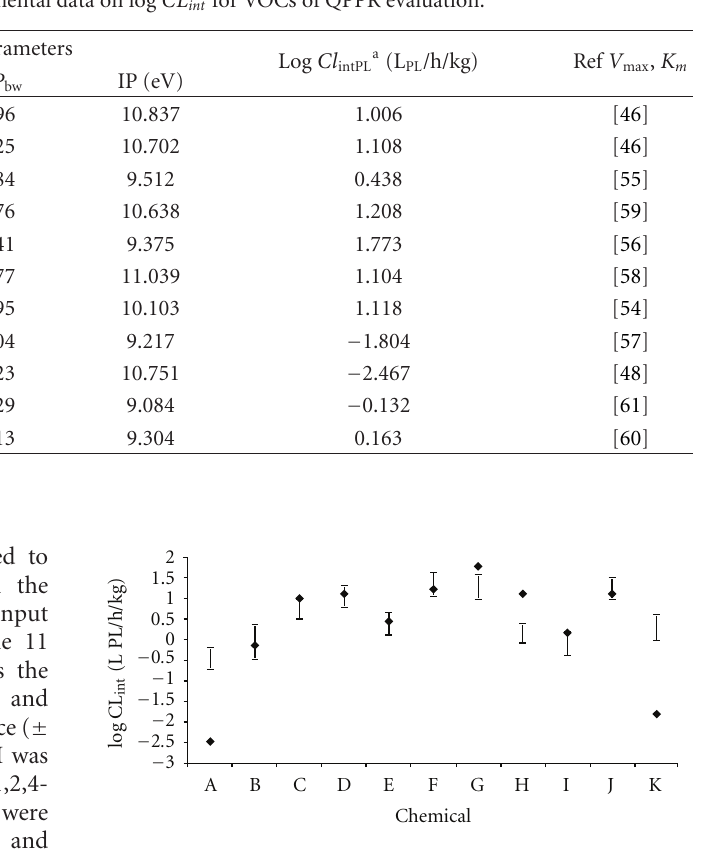
Figure 5: Comparison of the predicted log CL int (LMCI and UMCI) with the experimental data on 11 VOCs. The bars represent the QPPR predictions and the symbols the experi- mental values. A: 1,1,1-trichloroethane; B: 1,2,4-trimethylben- zene; C: 1,2-dichloroethylene ( trans -); D: bromoform; E: dibro- mochloromethane; F: ethylene; G: furan; H: halothane; I: o -xylene; J: propylene; K: